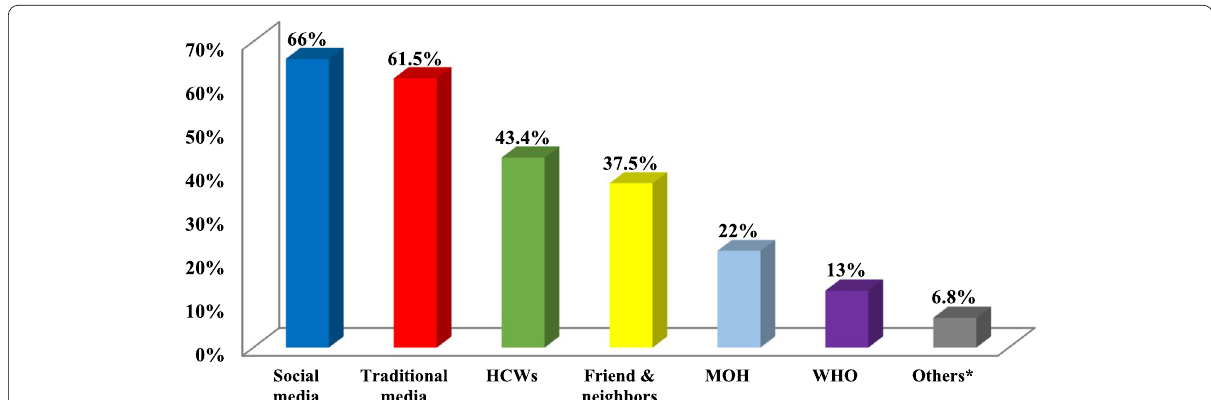
Fig. 1 Sources of information on COVID-19 among studied population in Damietta Governorate, Egypt, during COVID-19 pandemic (April 10 to July 15, 2020). *Others include spouse, family members, coworkers, community leaders, newspaper, Google